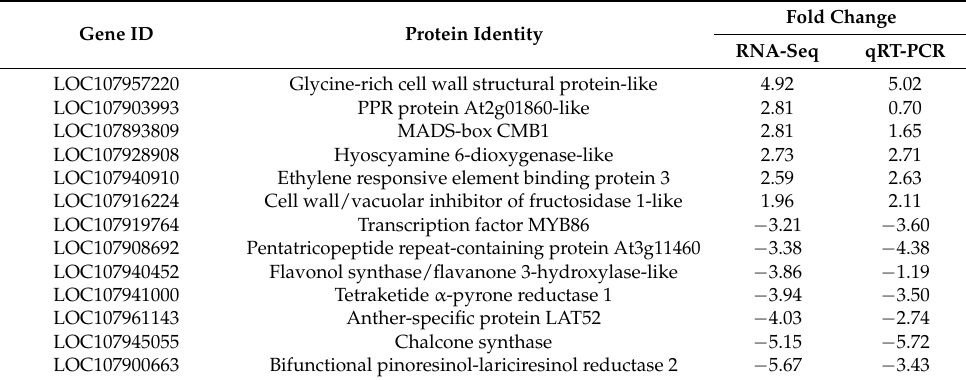
Table 3. qRT-PCR confirmation of the expression profiles of select